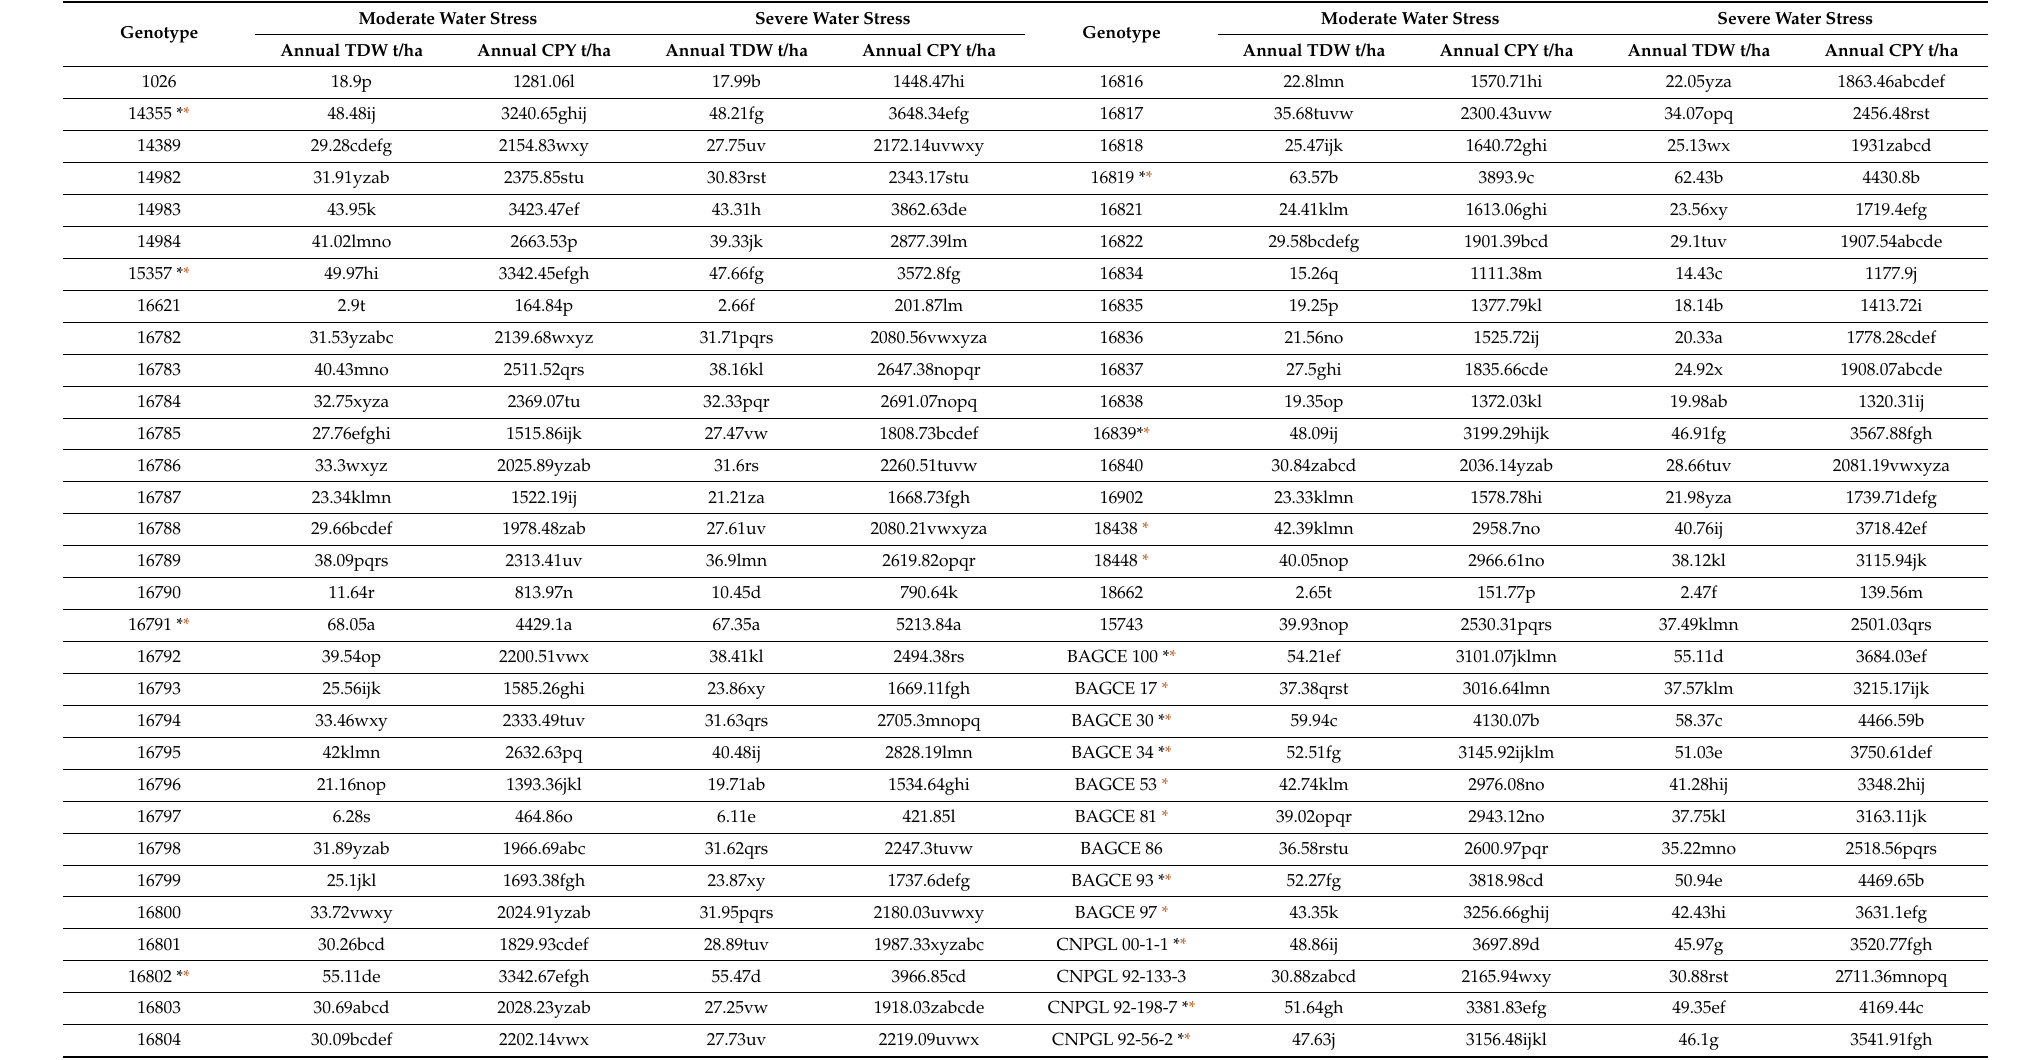
Table 5. Annual total dry weight and crude protein yield of the 84 Napier grass